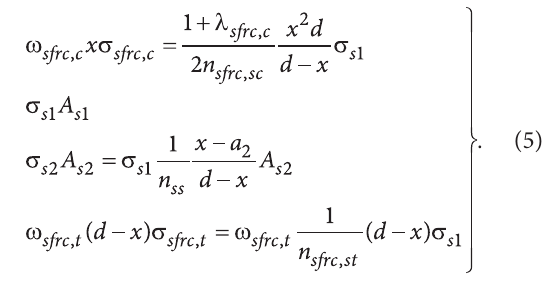
Fig. 3 . Strain and stress diagrams in normal section of SFRC slab with allowance for plastic strain of concrete in tension and in